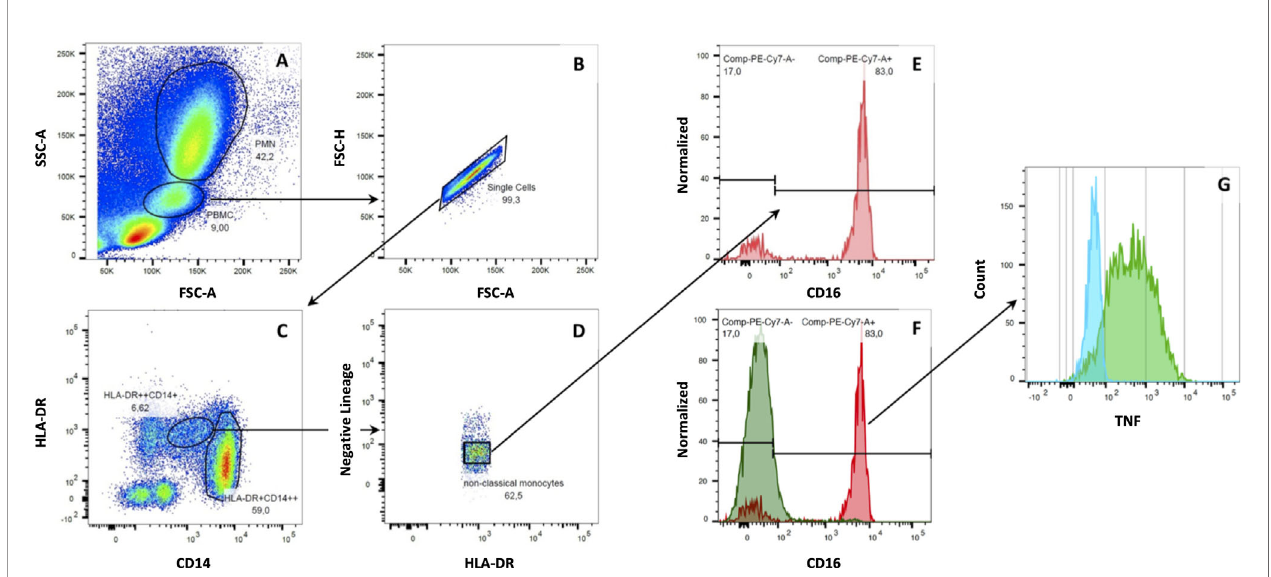
FIGURE 1 | Gating strategy for human monocytes. Monocytes were separated from neutrophil granulocytes and lymphocytes based on cell size and internal complexity. After excluding unwanted events and doublets, monocytes were analyzed amongst CD14 + and CD16 + cells. Then, monocyte subsets were detected within HLA-DR + cells, which were negative for B-cell (CD19 - ), T-cell (CD2 - ), NK-cell (NKp46 - and CD56 - ), or granulocyte (CD15 - ) markers. Here, the following monocytes subpopulations could be identi fi ed: classical monocytes (CD14 ++ CD16 - ), intermediate monocytes (CD14 ++ CD16 + ), and non-classical monocytes (CD14 dim CD16 ++ ). Cells without expression of CD14 and CD16 were considered dendritic cells of the peripheral blood (A – D) . After incubating human whole blood samples with LPS and mCRP for six hours, we found a down-regulation of CD16 on non-classical monocytes. Non-classical monocytes had to be backtracked within the HLA-DR + gate to assess their speci fi c cytokine expression (E – G)